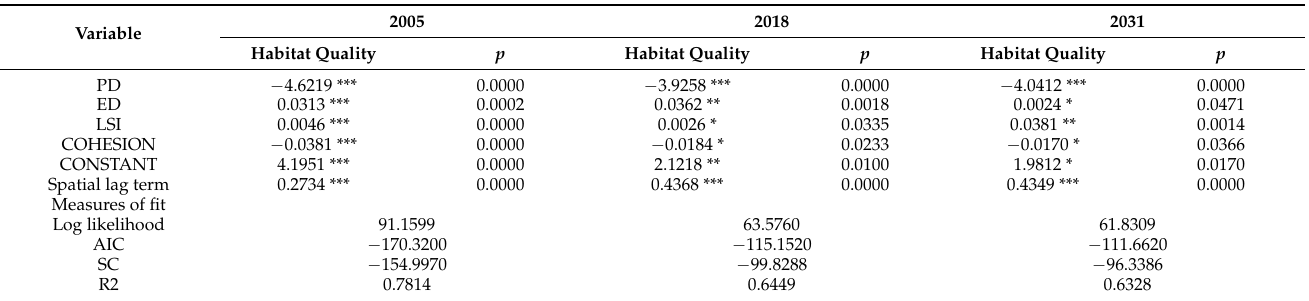
Table 6. Regression results of